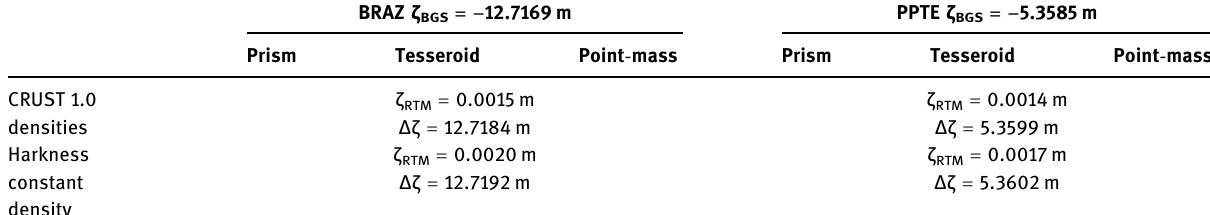
Table 1: RTM height anomaly values considering all the contributions of the entire integration area using prism, tesseroid, and point - mass approaches, with CRUST 1.0 densities, at both stations, and discrepancies in relation to the reference height anomalies